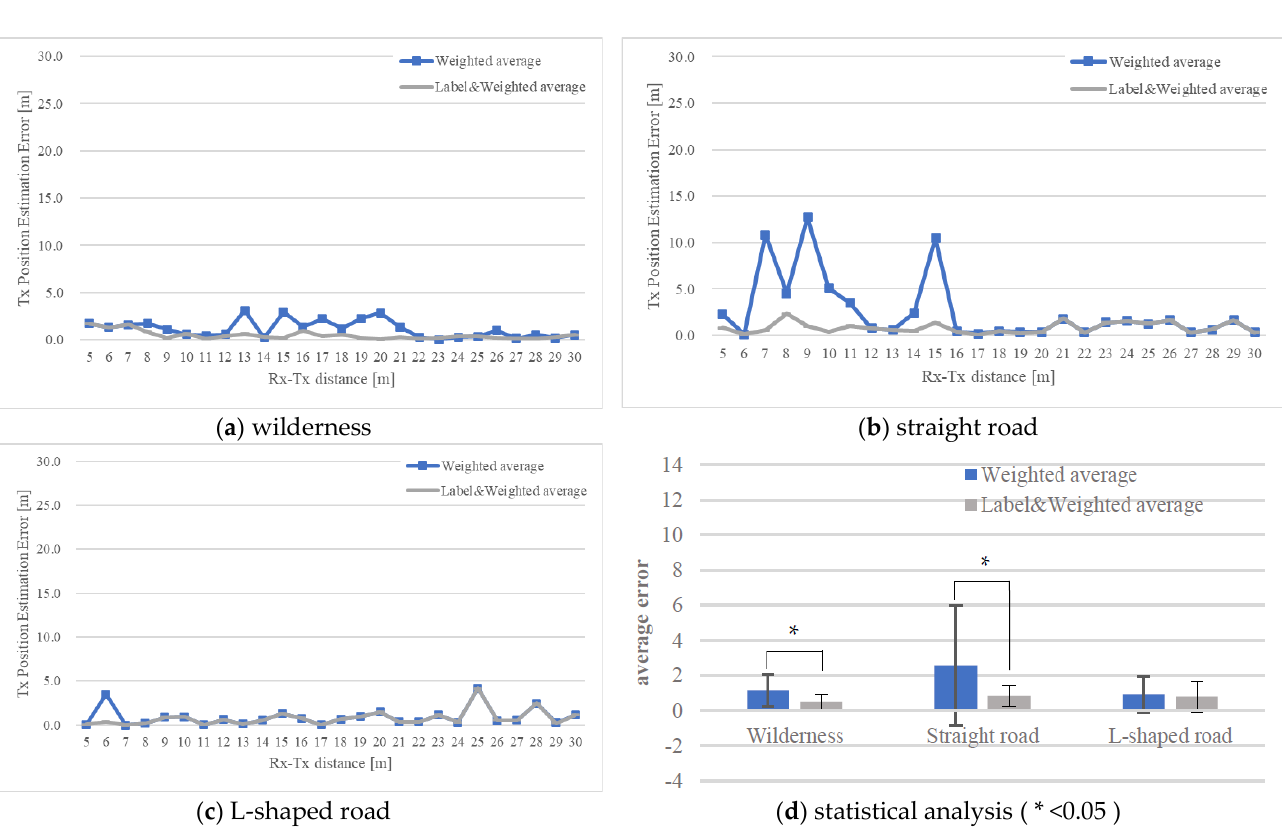
Figure 9. Position estimation results of the measurement simulation using the particle filter (five- step RSSI measurement). (a) wilderness; (b) straight road; (c); L-shaped road; (d) statistical analysis.